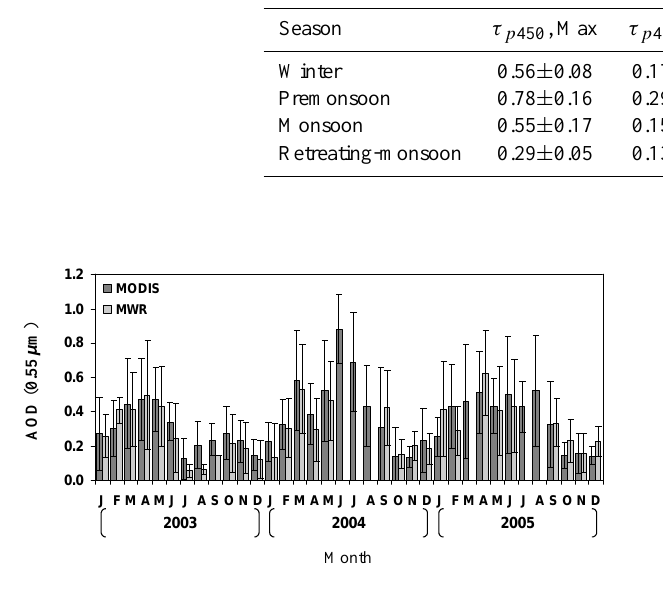
Figure 7 : Monthly averaged AOD at 0.55 µ m wavelength over Dibrugarh during the year Fig. 7. Monthly averaged AOD at 0.55 µ m wavelength over Di- 2003 to 2005 retrieved from MODIS and MWR. The error bars represent the standard brugarh during the year 2003 to 2005 retrieved from MODIS and deviation of AOD for that month. MWR. The error bars represent the standard deviation of AOD for that month.